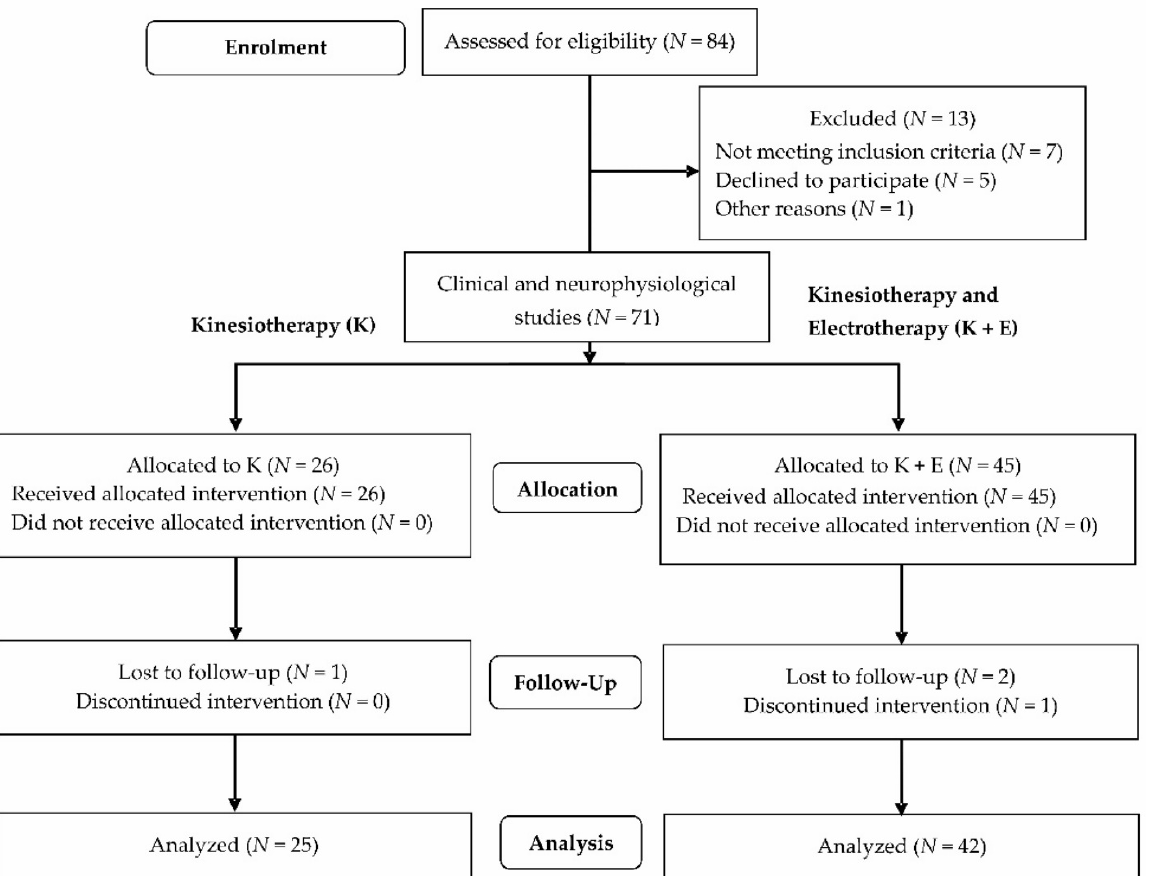
Figure 1. Flow chart of the study.